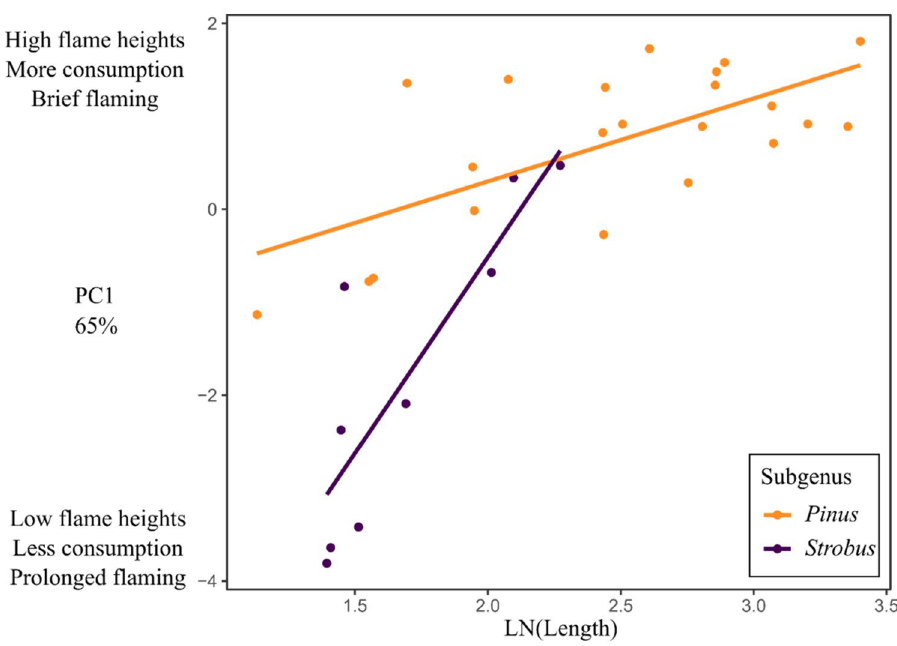
Figure 3. Relationship between pine needle length (log transformed) to the first principal component (PC1) of combined flammability for the 31 North American pine species, segregated by subgenus ( Pinus and Strobus